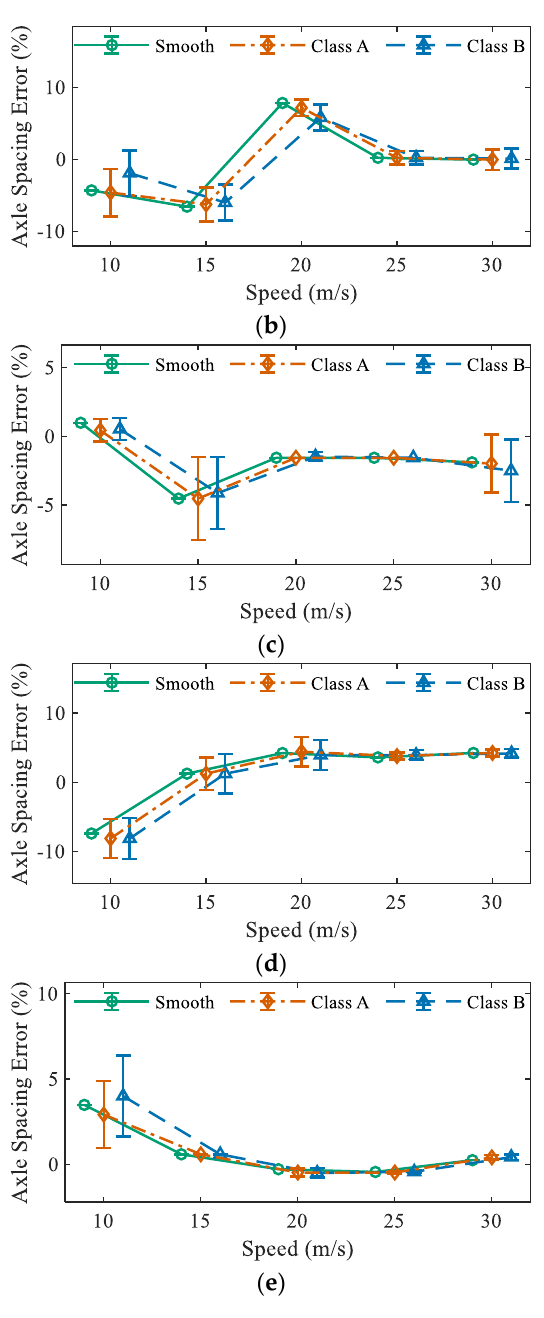
Figure 12. Identified axle spacing error: ( a ) 2-axle truck: AS; ( b ) 3-axle truck: AS1; ( c ) 3-axle truck: AS 2 ; ( d ) 5-axle truck: AS1; and ( e ) 5-axle truck: AS2.